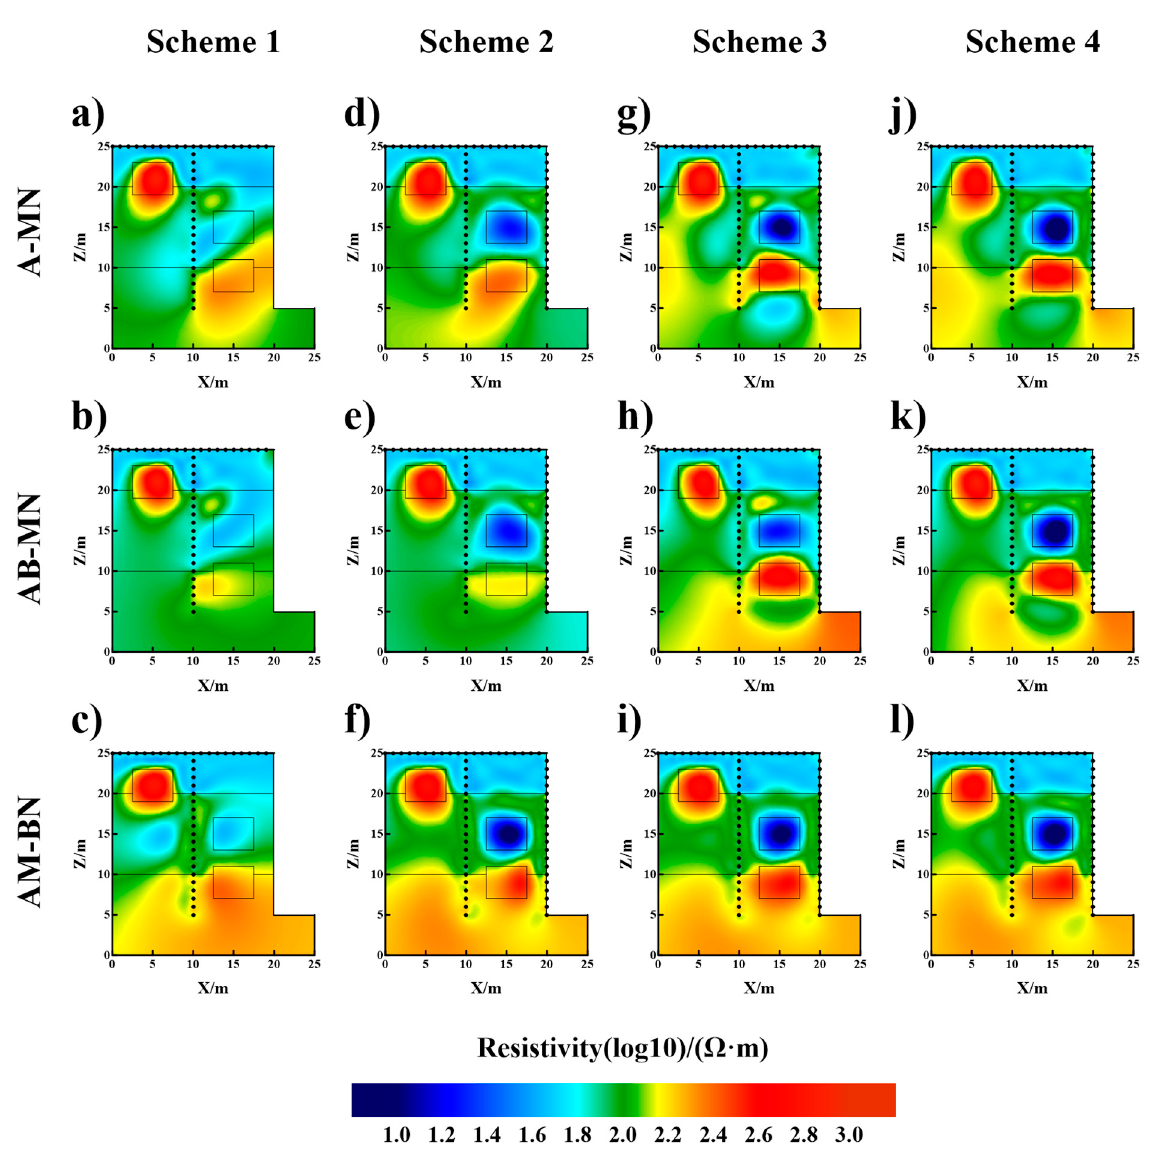
Figure 7. Resistivity images for four combined schemes: ( a – c ) surface ERT scheme & BS-ERT scheme, ( d – f ) surface ERT scheme, BS-ERT scheme & SC-ERT scheme, ( g – i ) surface ERT scheme, BS-ERT scheme & BC-ERT scheme, ( j – l ) surface ERT scheme, BS-ERT scheme, SC-ERT scheme, BC-